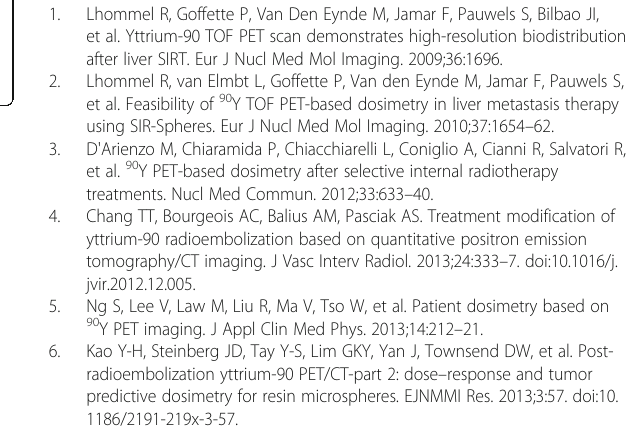
Additional file 1: Figure S10. Case studies representing each of the scenarios discussed in the manuscript with regards to lesional dose – response: high average dose (>50 Gy) achieving a CMR (a); intermediate average dose (20 – 50 Gy) with a low dose CoV achieving a PMR (b); intermediate average dose (20 – 50Gy) with a high dose CoV achieving SMD (c); low average dose (<20 Gy) achieving PMD (d); and the anomaly of a high average dose (<50 Gy) resulting in only SMD (e). Each row represents a transverse slice through the baseline FDG PET (left), 90 Y PET derived dosemap ( centre ), and follow-up FDG PET ( right ). The crosshairs identify the lesion of interest. (ZIP 529